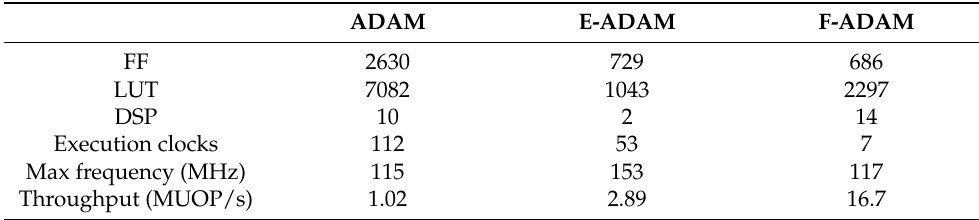
Table 2. The implementation details of the proposed